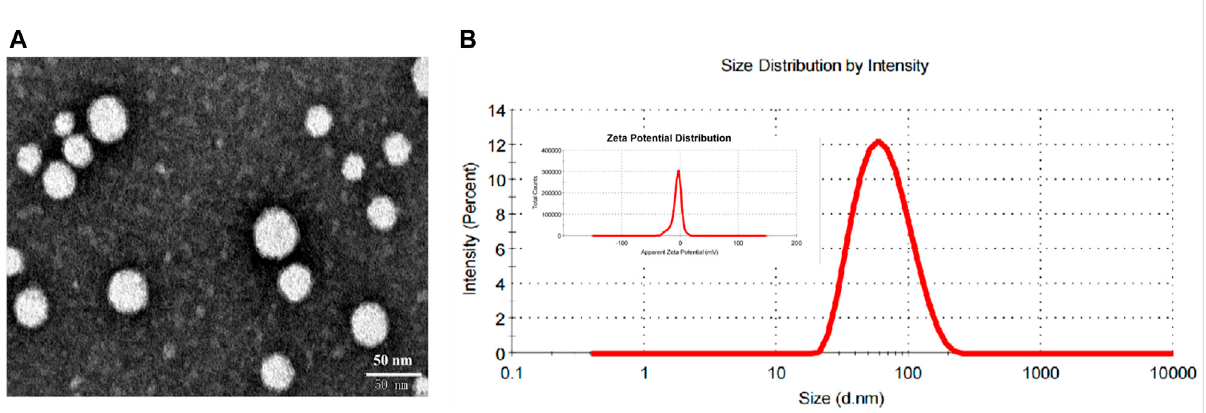
FIGURE 2 (A) RepresentativeTEMimageofcRGD-ICG-uPA NPs. (B) Thesizedistributionandzetapotential distributionofcRGD-ICG-uPANPsmeasured by dynamic light